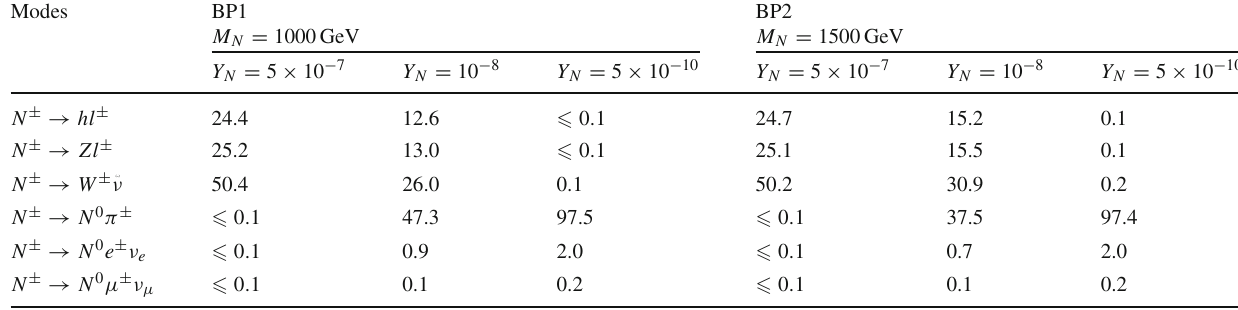
Table 1 Masses of the Type-III fermions ( M N ) and their branching ratios (in %) for the different decay modes of N ± . Here N ± decay branching fractions are for Y N = 5 × 10 − 7 , 1 × 10 − 8 and 5 × 10 − 10